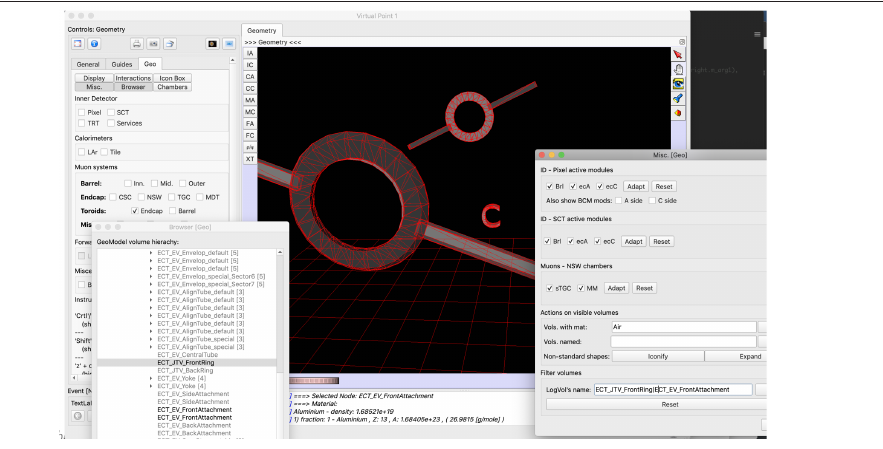
Figure 5: Two clashing volumes in a complex Muon geometry, detected running a geometry overlap check with